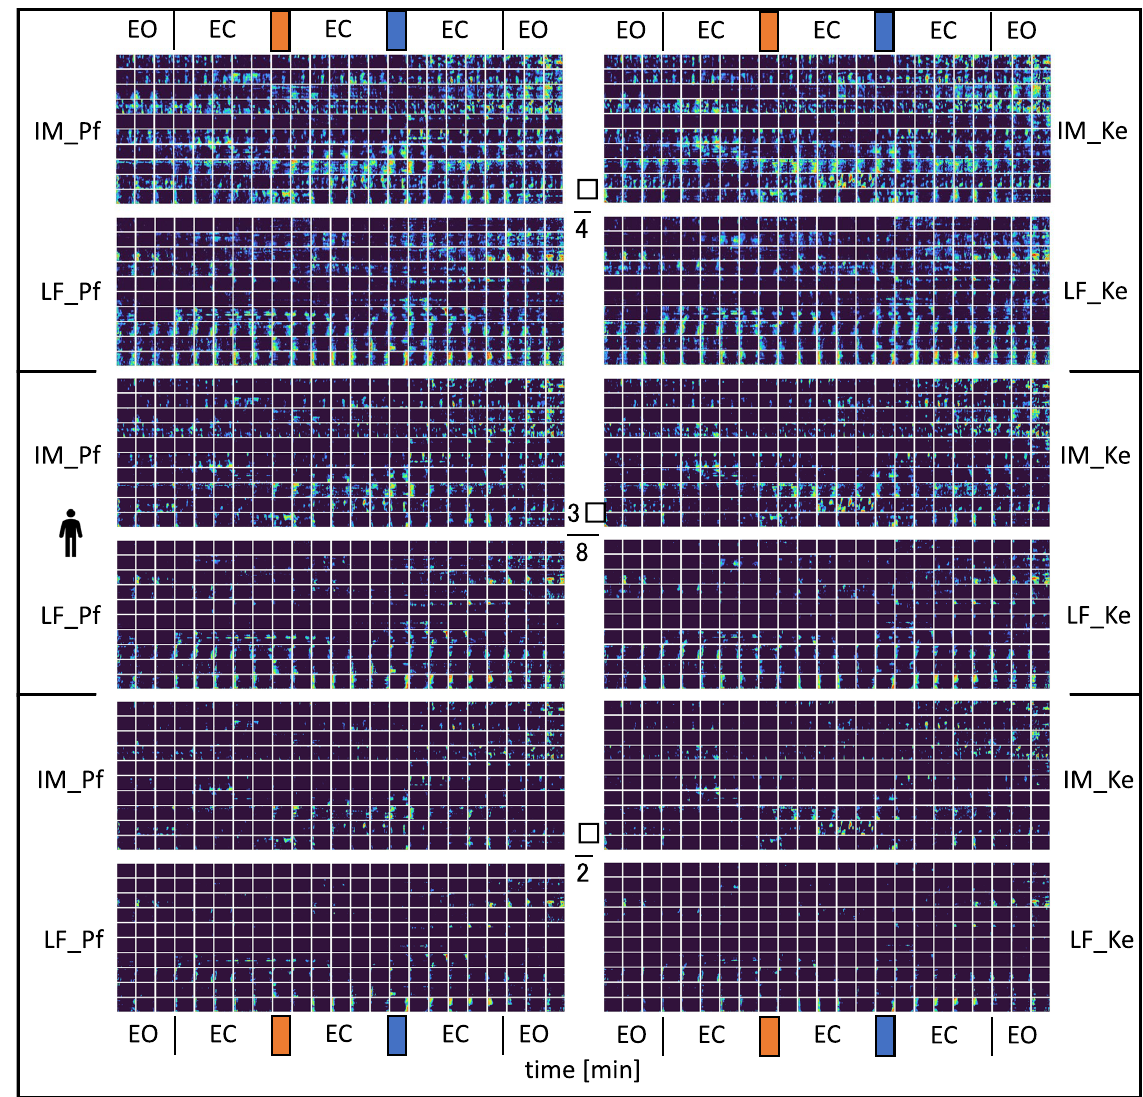
Figure 11. Spatial phase shift distribution matrices indexing desynchronization for low and intermediate frequency (LF, and IM, resp.) bands according to boundaries used by Pfurtscheller (Pf, left column) or Keller (Ke, right column) for individual participants (horizontal lines of squares) of the main group (n = 10). EO = eyes open, EC = eyes closed; orange bar at top: cold water test, blue bar at top: ambient water test. From top to bottom, colour coded points display thresholds for relative phase shift intervals from π/4 rad to π rad, 3π/8 rad to π rad, and π/2 rad to π rad: dark blue < blue < green < yellow. Red indexing counterphase with the reference. Plots show only minute differences between Pfurtscheller and Keller frequency